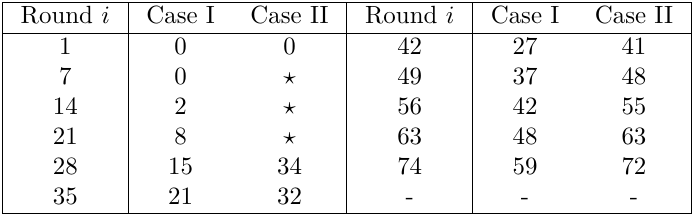
Table 4: Lower bounds on the minimum number of differentially/linearly active sboxes for up to 74 rounds of WAGE . “ ? ” means no solution